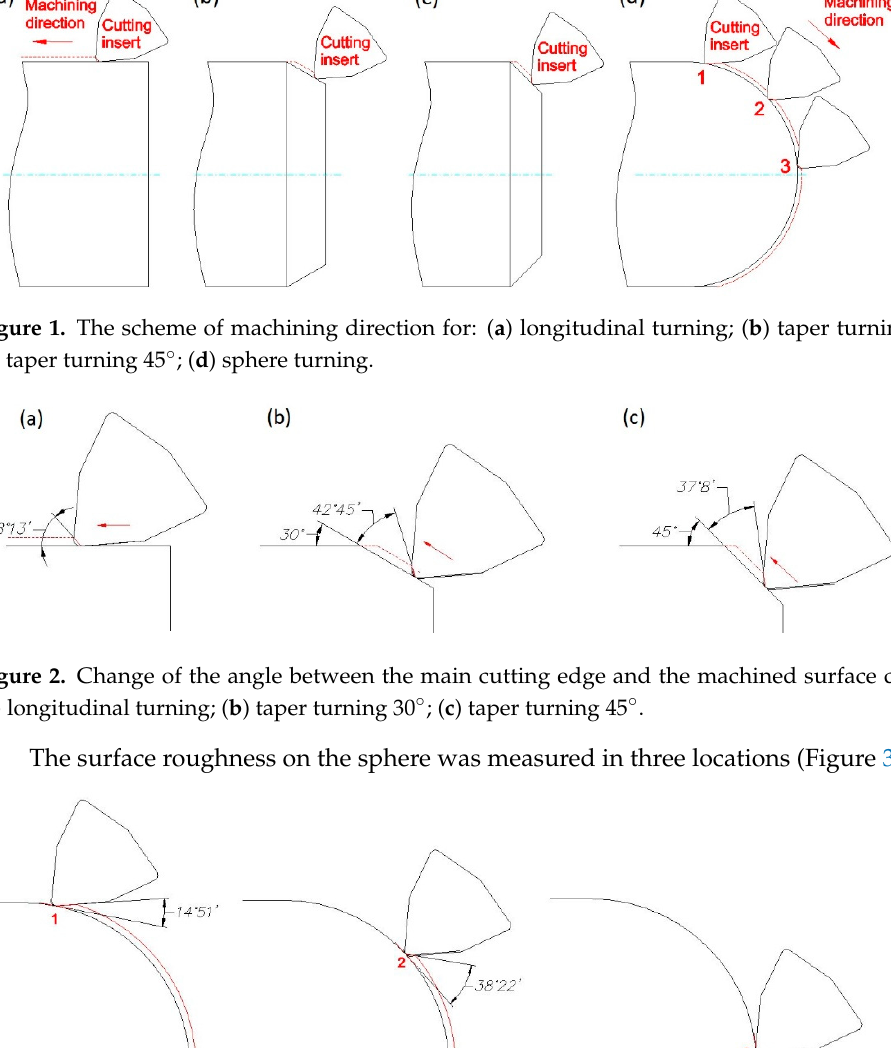
Figure 3. Change of the angle between the main cutting edge and the machined surface during sphere turning.